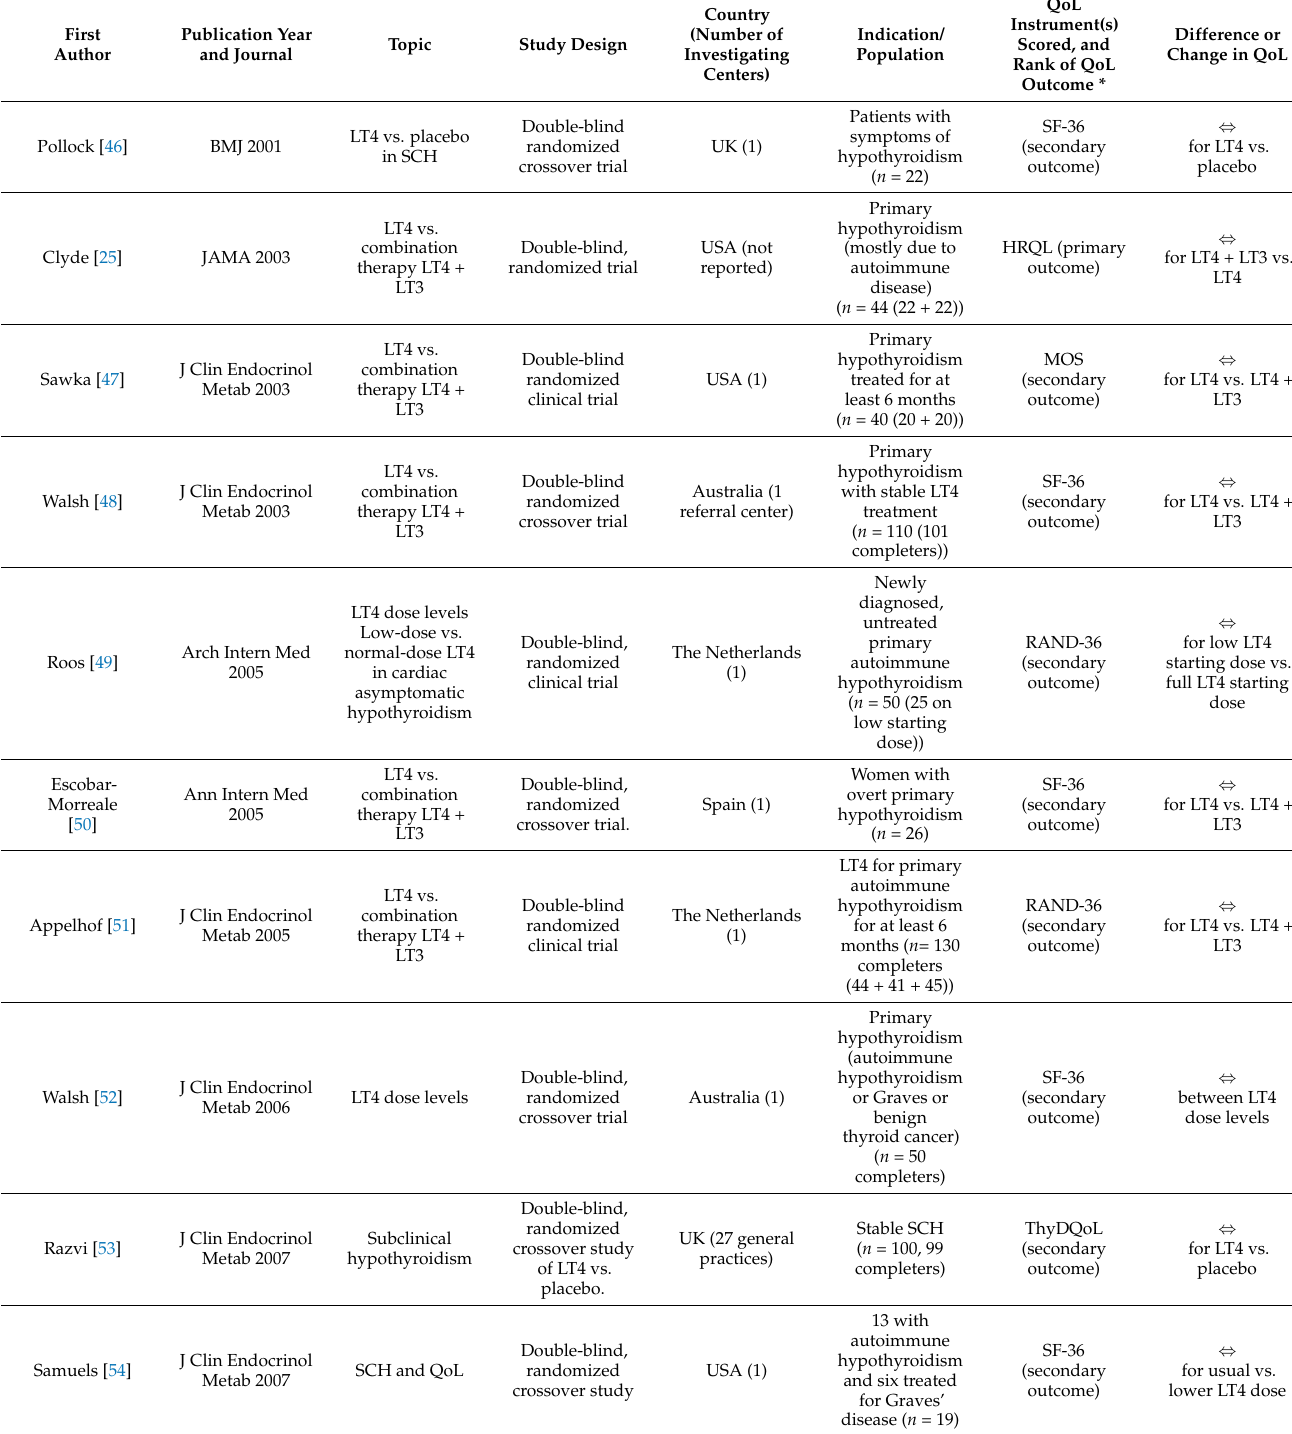
Table 2. Reviewed randomized studies, by year of